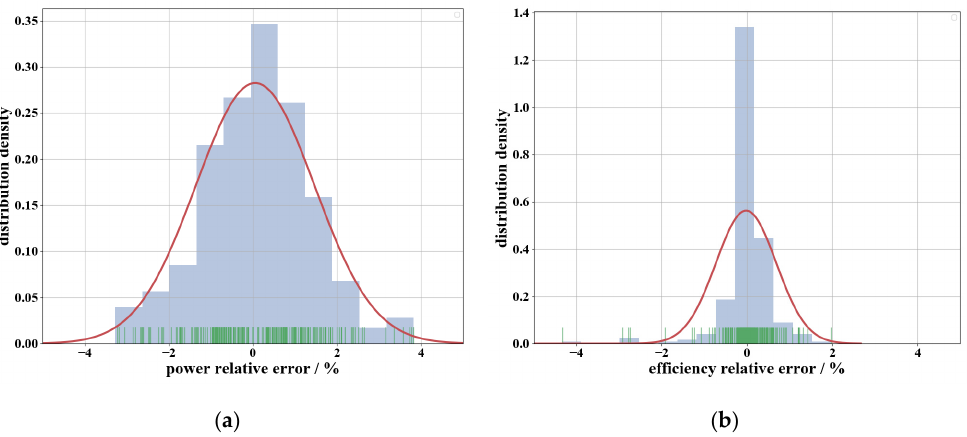
Figure 14. The distribution density of relative error: ( a ) power; ( b ) efficiency